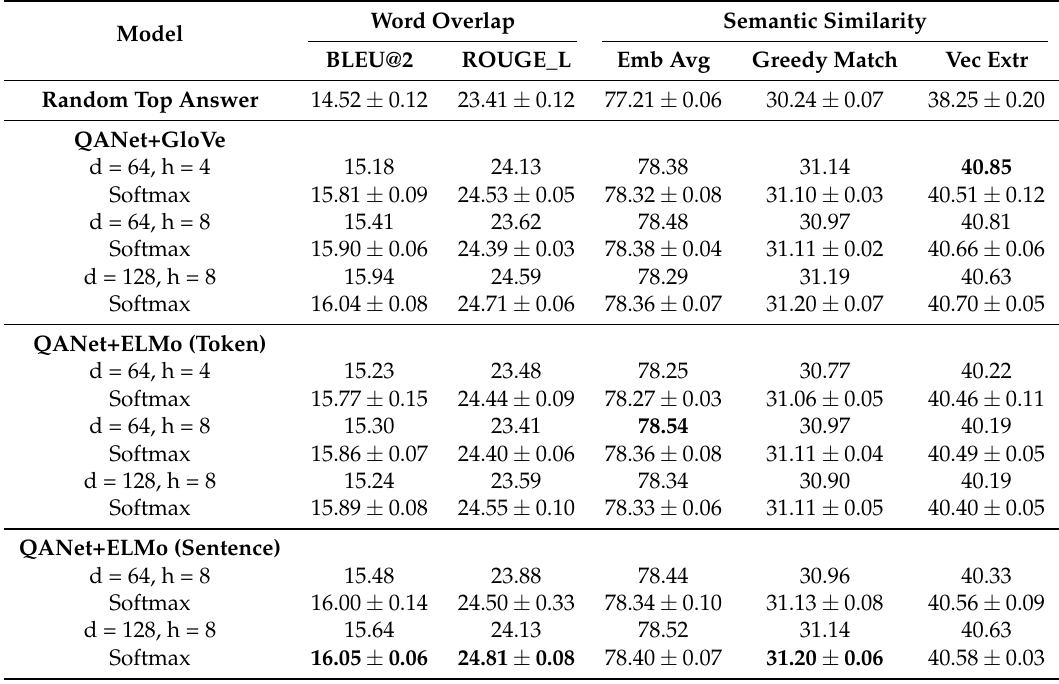
Table 4. Main task: re-ranking the top K = 5 answers returned by the IR and the seq2seq models. Word Overlap Semantic Model